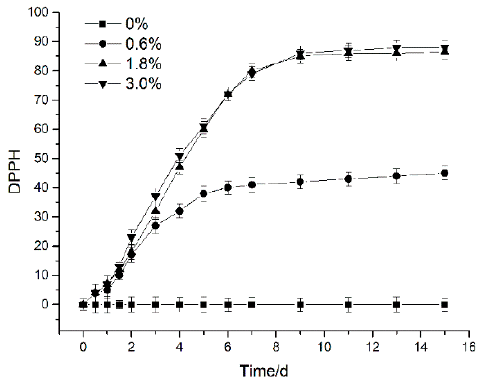
Figure 1. DPPH scavenging ability of film containing tea polyphenols.